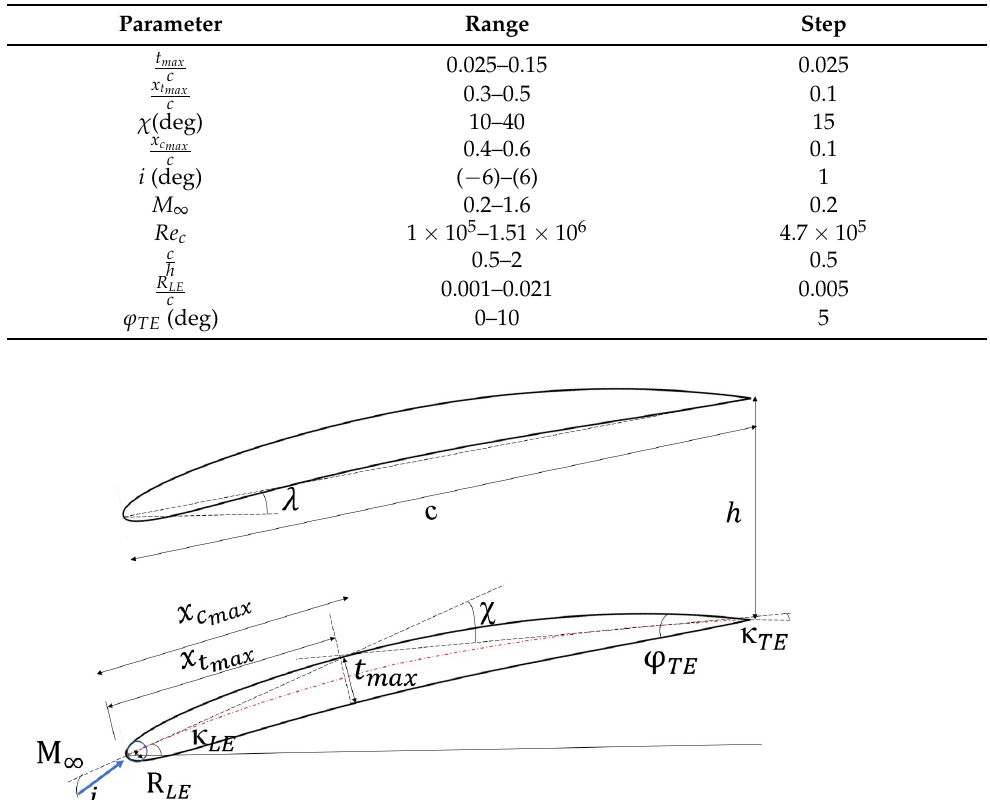
Table 1. Ranges for data generation from computational fluid dynamics (CFD) used in artificial neural network and steps.